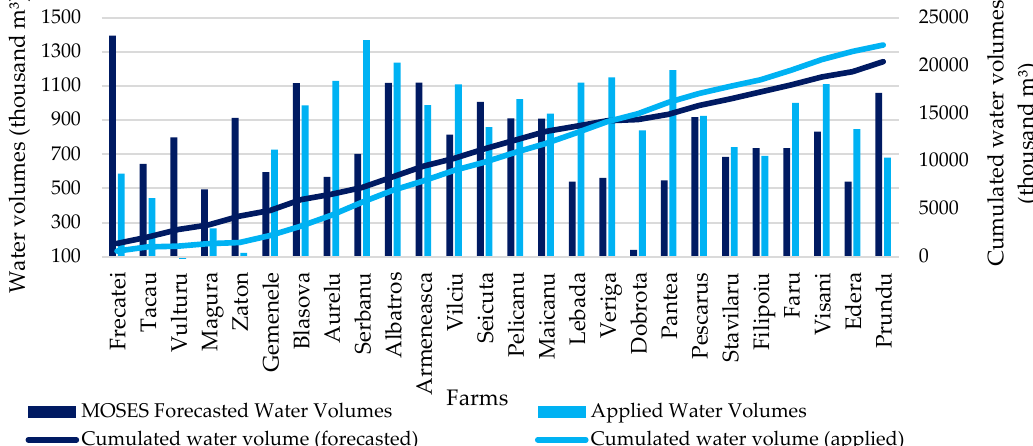
Figure 12. Forecasted and applied water volumes in 2018 at the level of farms located in the IMB Irrigation District.